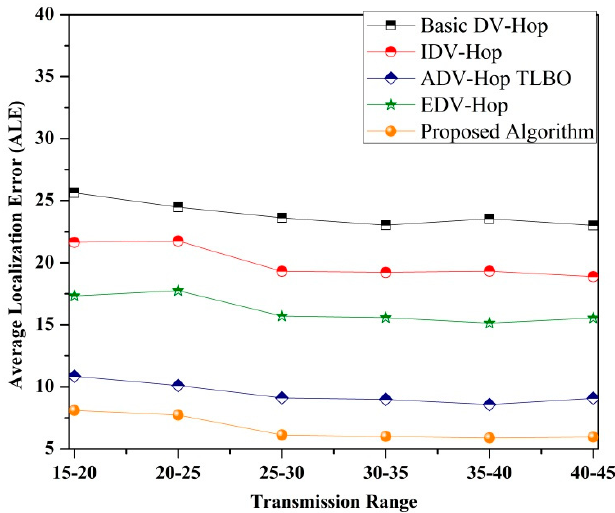
Figure 11. Impact of variable transmission range on ALE (DOI = 0).